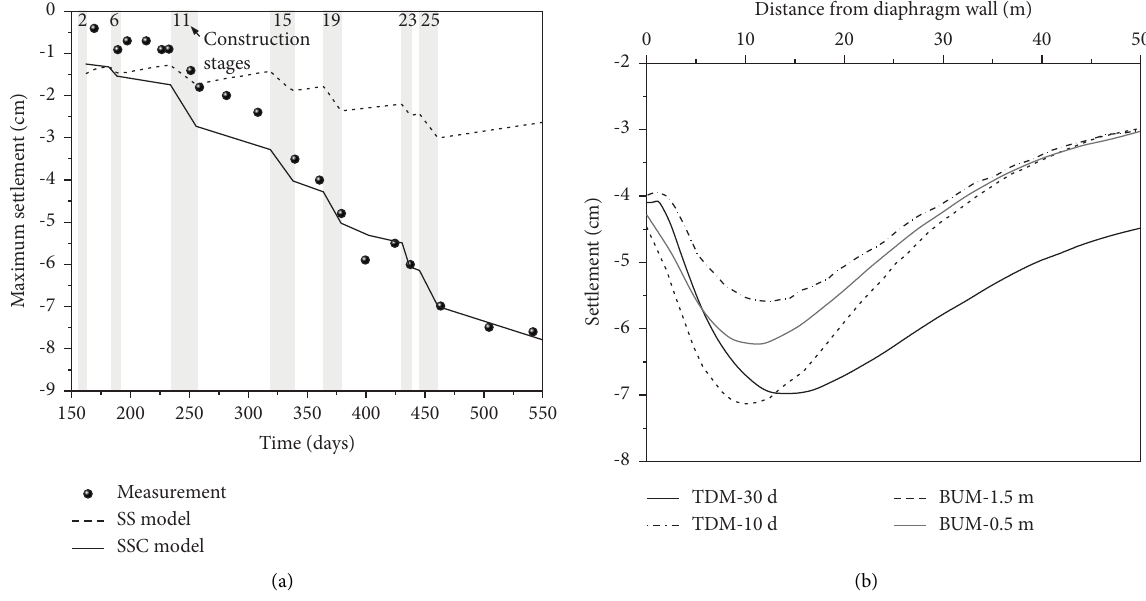
Figure 6: Soil creep effect on ground surface settlements: (a) time-histories of measured and FEM-calculated maximum settlements; (b) comparison of settlement troughs in different cases, modified from